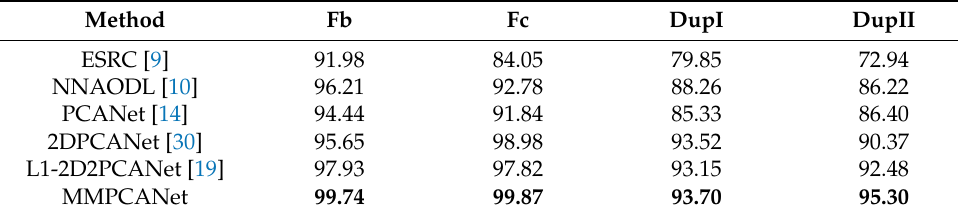
Figure 9. Average accuracy on FERET database. Table 7. Average Recognition Rate (%) on FERET